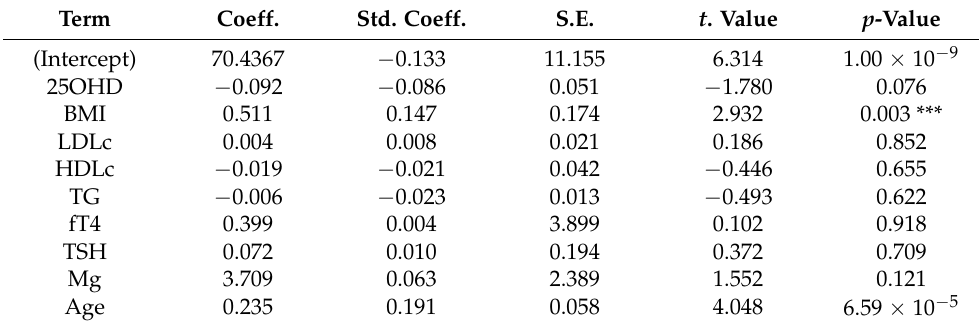
Table 3. A linear regression model describing the effects of 25OHD and other potentially relevant covariates on blood glucose in the study sample. Coeff. Term Coeff. Std. Coeff. S.E. t .